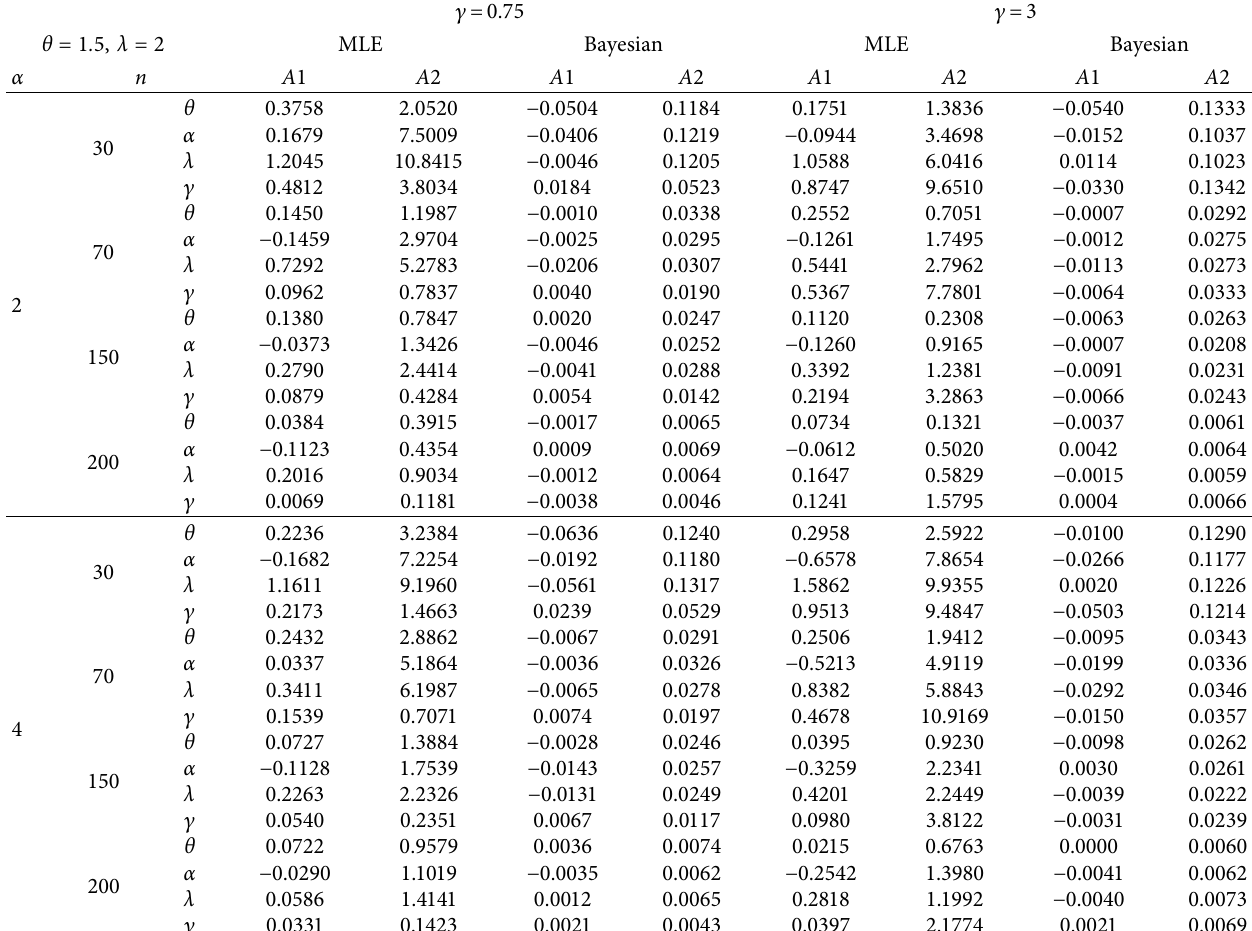
Table 3: A 1 and A 2 of MOEGM parameters by MLE, and Bayesian when. α � 1 . 5 , λ � 2. c � 0.75 c �